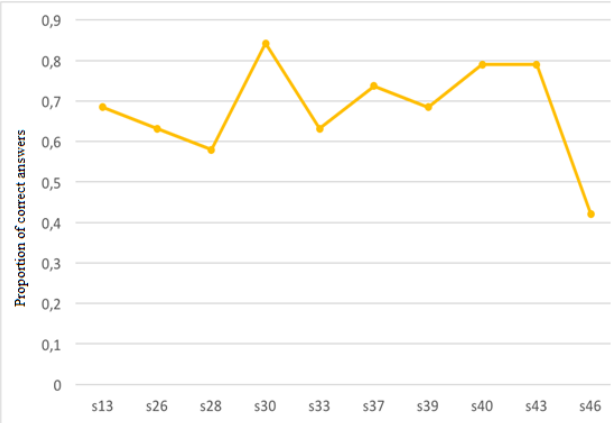
Graphic 6. Proportion of expected answers for adjunct sentences along the experiment